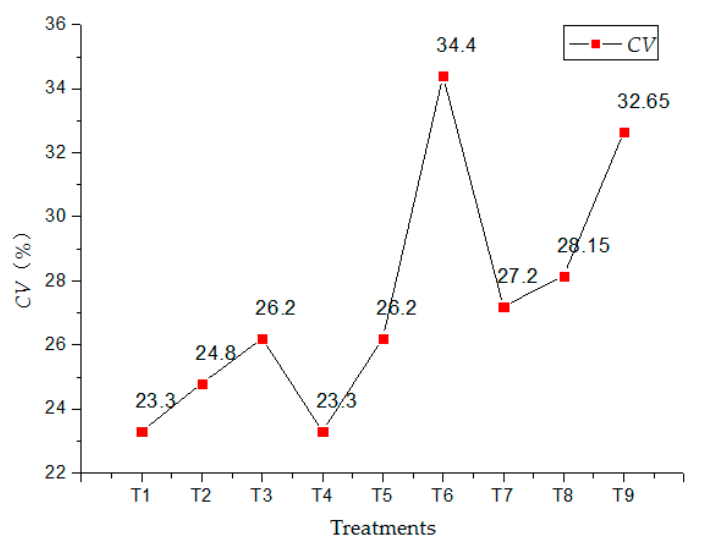
Figure 6. Droplet deposition uniformity of each treatment by coefficients of variation ( CVs ).